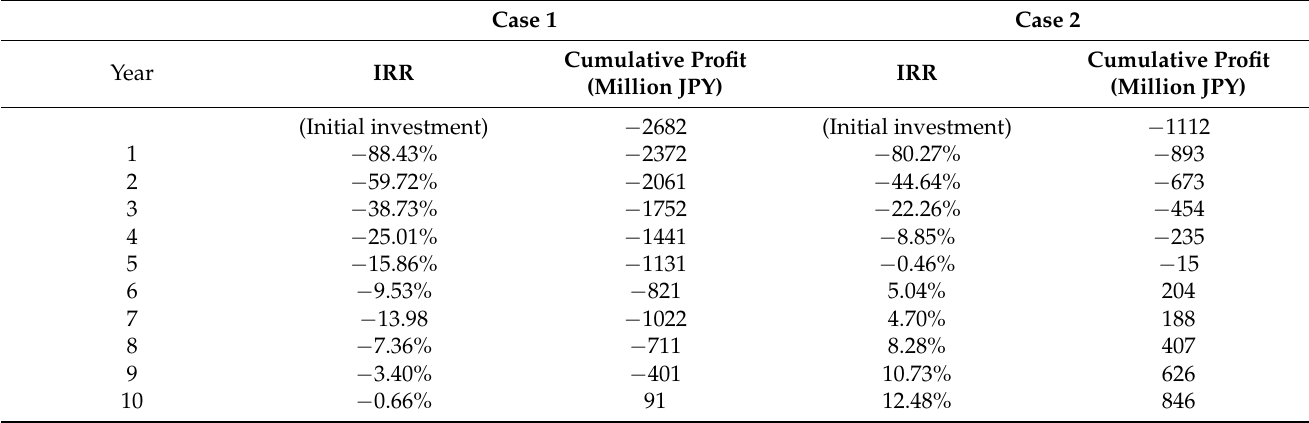
Table 9. IRR and cumulative profit (when mitigation conditions are changed) *3. Case